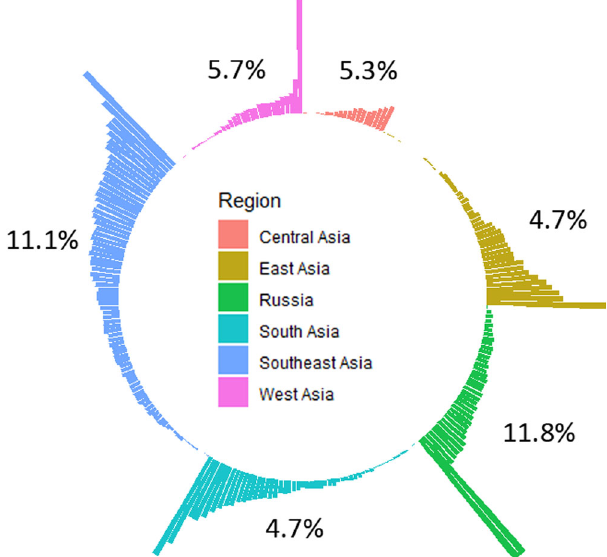
Fig. 4 Circular barplot of the ecological representativity, de fi ned as the percentage of ecoregions within the network of PAs for different Asian regions. Numbers denote the median of ecological representativeness per each region. Table 2 Results of generalized linear models testing different hypotheses on the association between the percentage of ecoregions protected by the PA network in 2020 and ecological and geopolitical factors in Asian